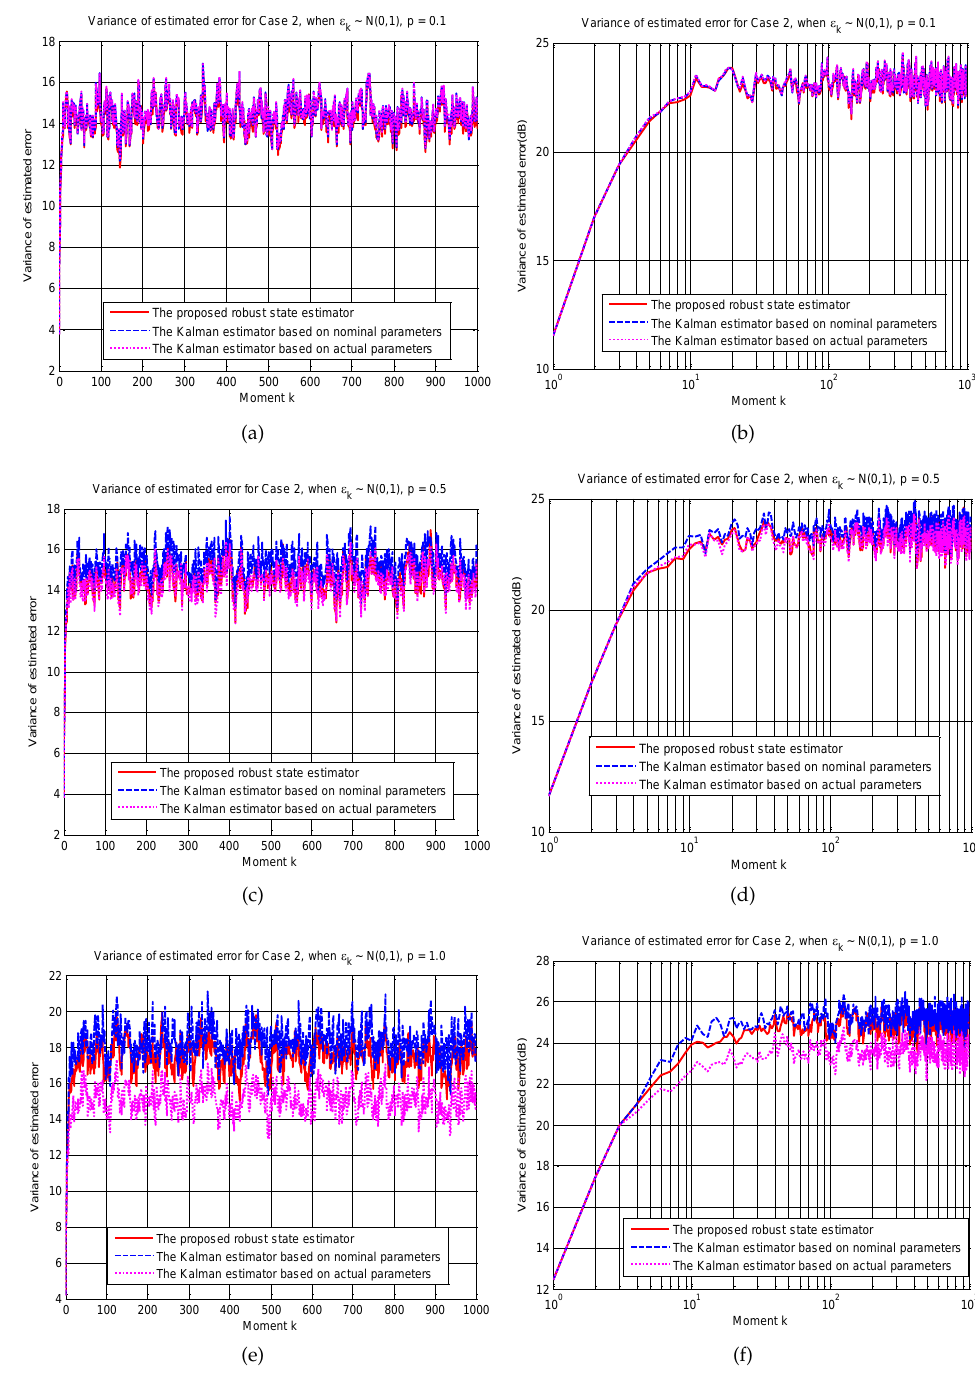
Figure 6. The experimental results of Case